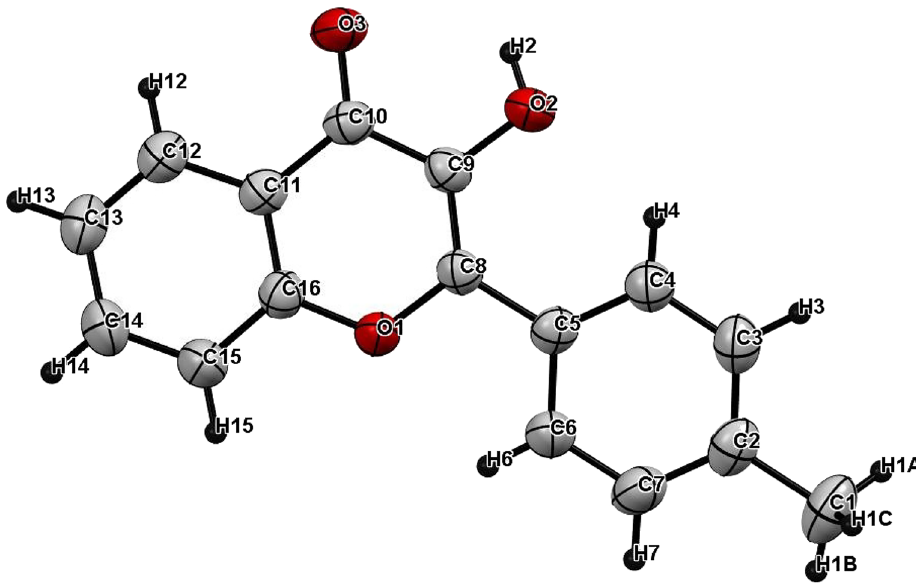
Figure 6. X-ray crystal structure of 12.